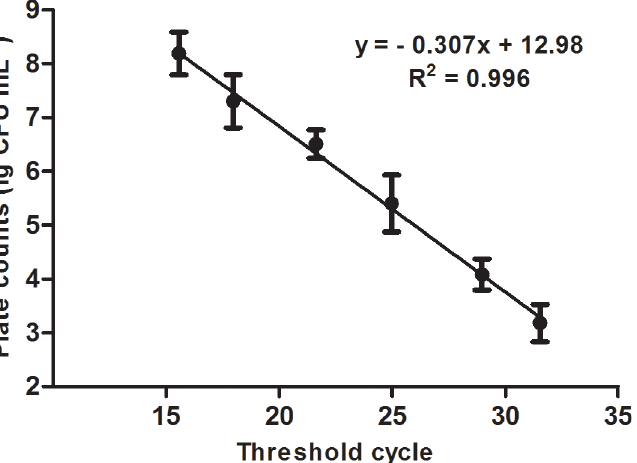
Fig 2. Correlation between bacterial population on agar plates and threshold cycle (Ct) of PMAxx-qPCR for culturable Clavibacter michiganensis subsp. michiganensis ( Cmm ). The final concentration of PMAxx used in bacterial cells treatment was 20 μM. The X-axis indicates the Ct value of PMAxx-qPCR and the Y-axis indicates the lg CFU mL -1 of bacterial